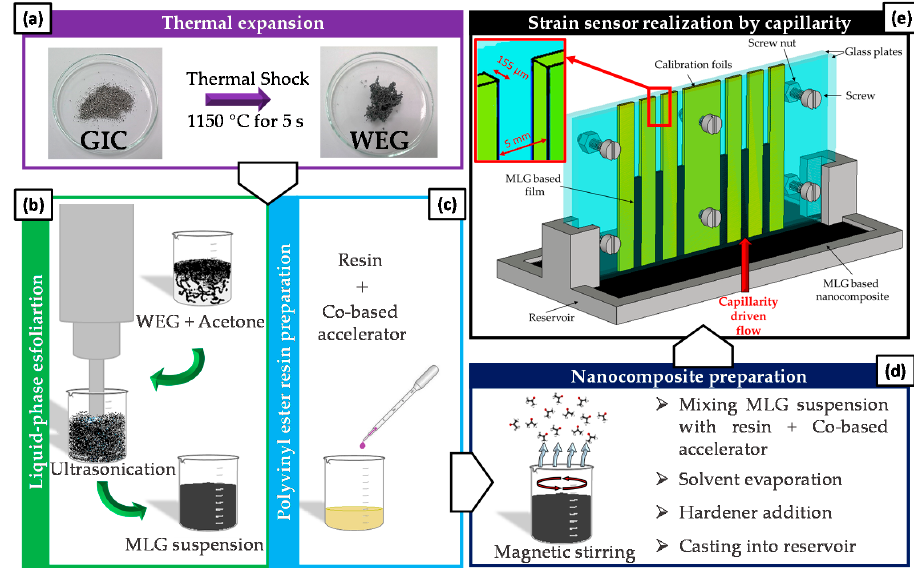
Figure 1. Schematic of the MLG/resin composite laminae fabrication route. GIC, graphite intercalation compounds; WEG, worm-like expanded graphite. ( a ) photographs of GIC as purchased and WEG obtained after thermal shock; ( b ) schematic of the MLG suspension preparation; ( c ) schematic of the composite solution processing technique; ( d ) nanocomposite preparation steps; ( e ) capillary rise setup scheme.